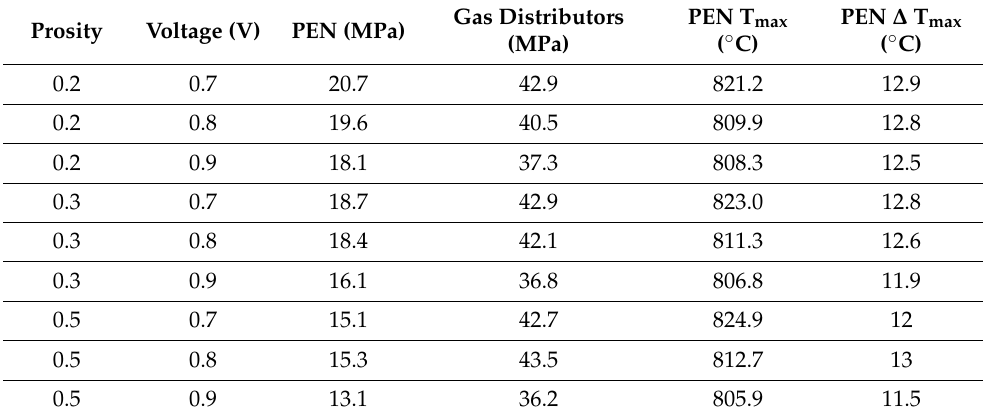
Table 4. Maximum principal stresses and temperatures at different cell voltages and porosities